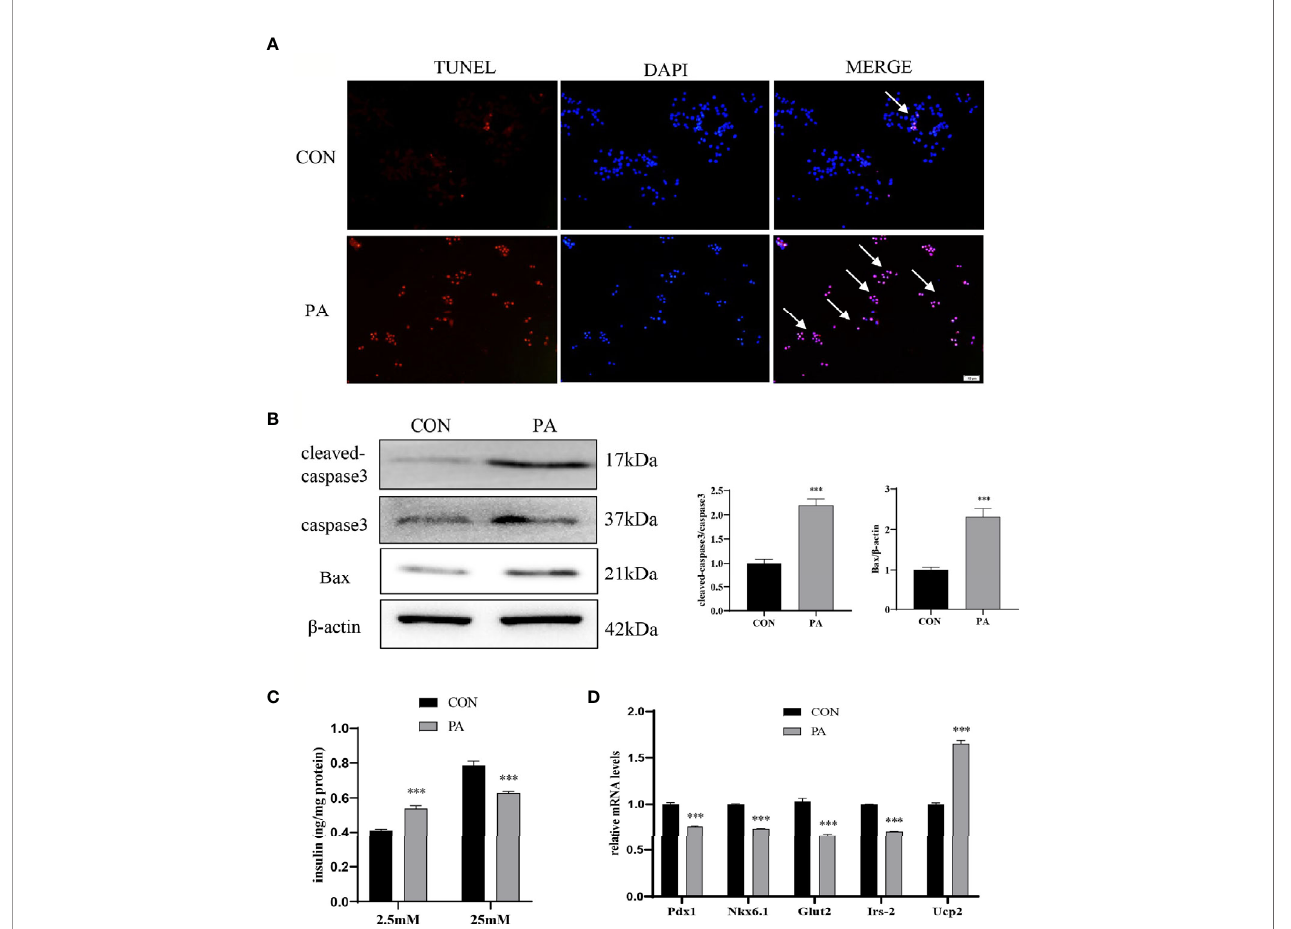
FIGURE 2 | PA induced INS-1 cells dysfunction. INS-1 cells were incubated with PA (0.4mM) for 24h. (A) Apoptosis was assessed by terminal deoxynucleotidyl transferase-mediated dUTP-biotin nick end labeling (TUNEL) assay, scale bar=50 m m. (B) The protein expressions of cleaved-caspase3 and Bax were detected by Western blot. (C) Glucose-stimulated insulin secretion (GSIS) was performed to show the dysfunction of insulin secretion after PA stimulation. (D) The mRNA expressions of insulin secretion-related genes, including Pdx1, Nkx6.1, Irs-2, Glut2, and Ucp2. Data are expressed as the mean ± SEM. ***p < 0.001 (compared with control